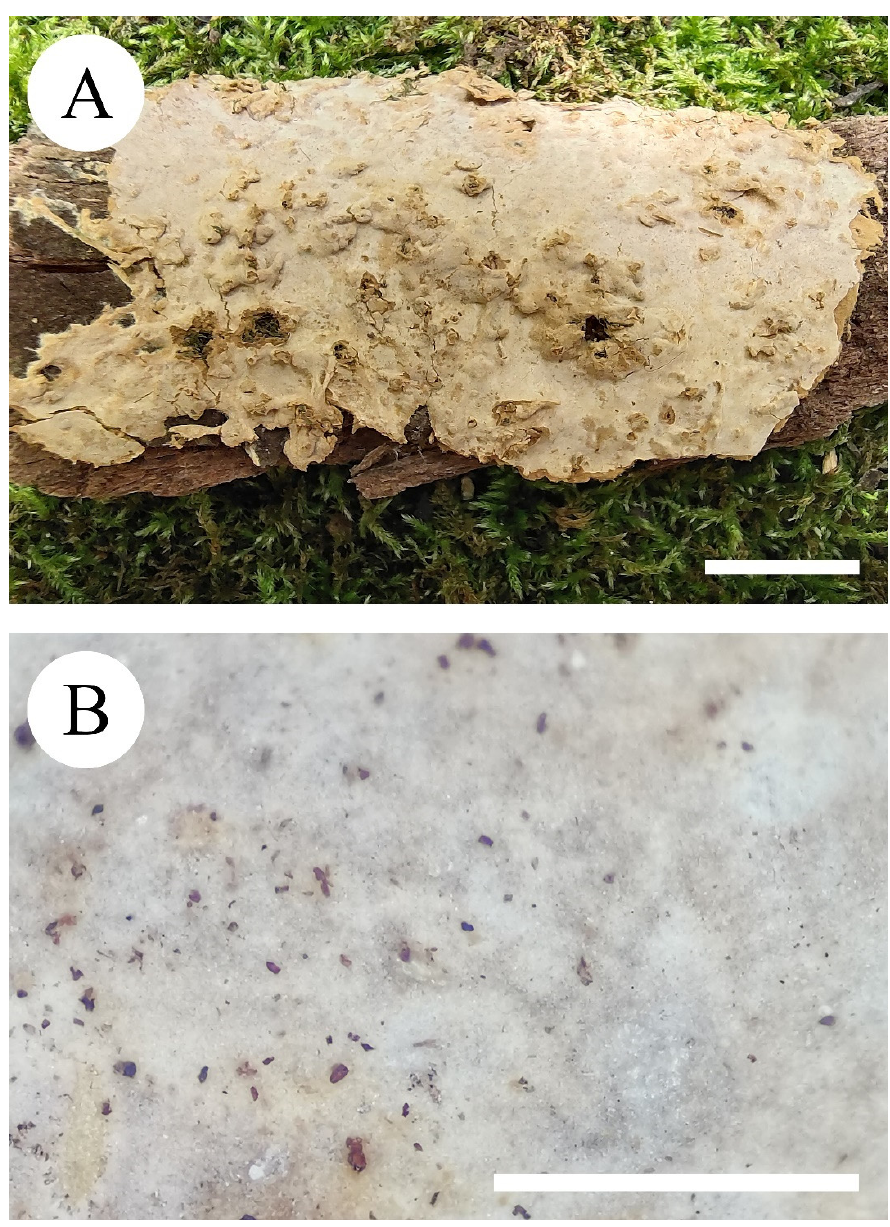
Figure 5. Basidiomata of Rhizochaete grandinosa (holotype). Bars: ( A ) = 1 cm and ( B ) = 1 mm.